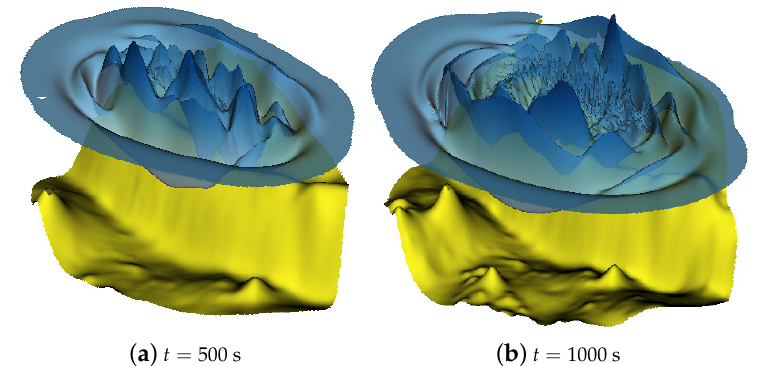
Figure 20. Active generation: the bottom and the free surface elevation computed with the domain adaptivity method.